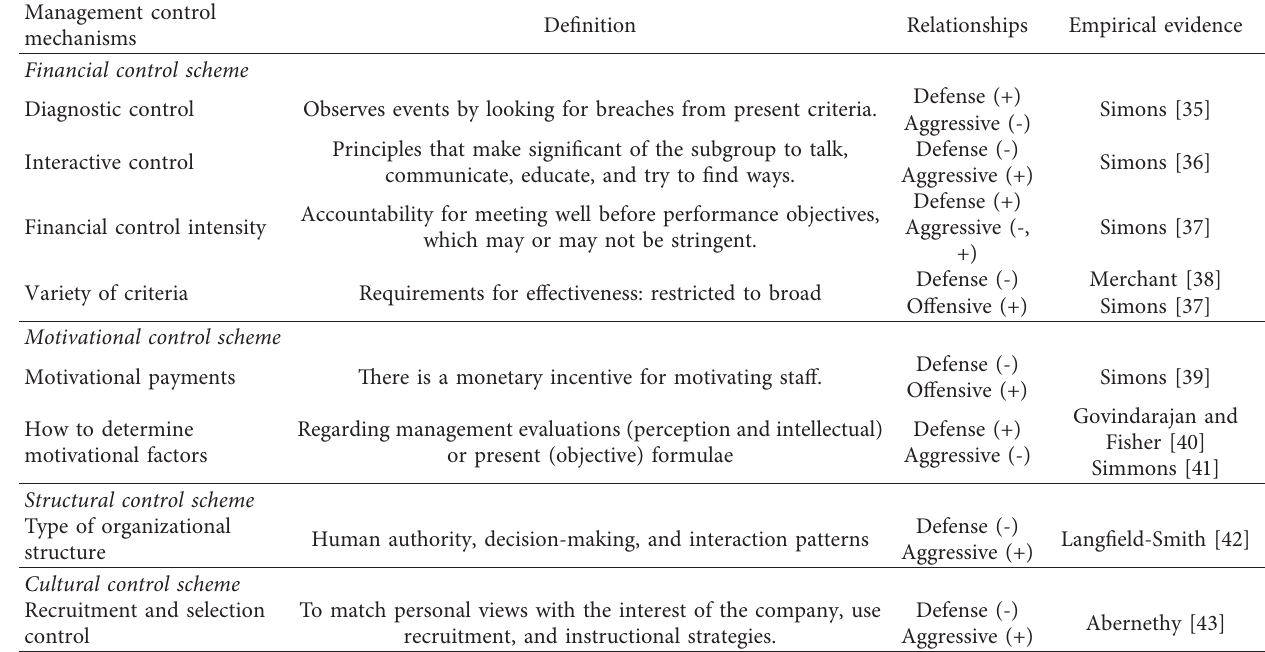
Table 1: Principles and a review of objective research for management control